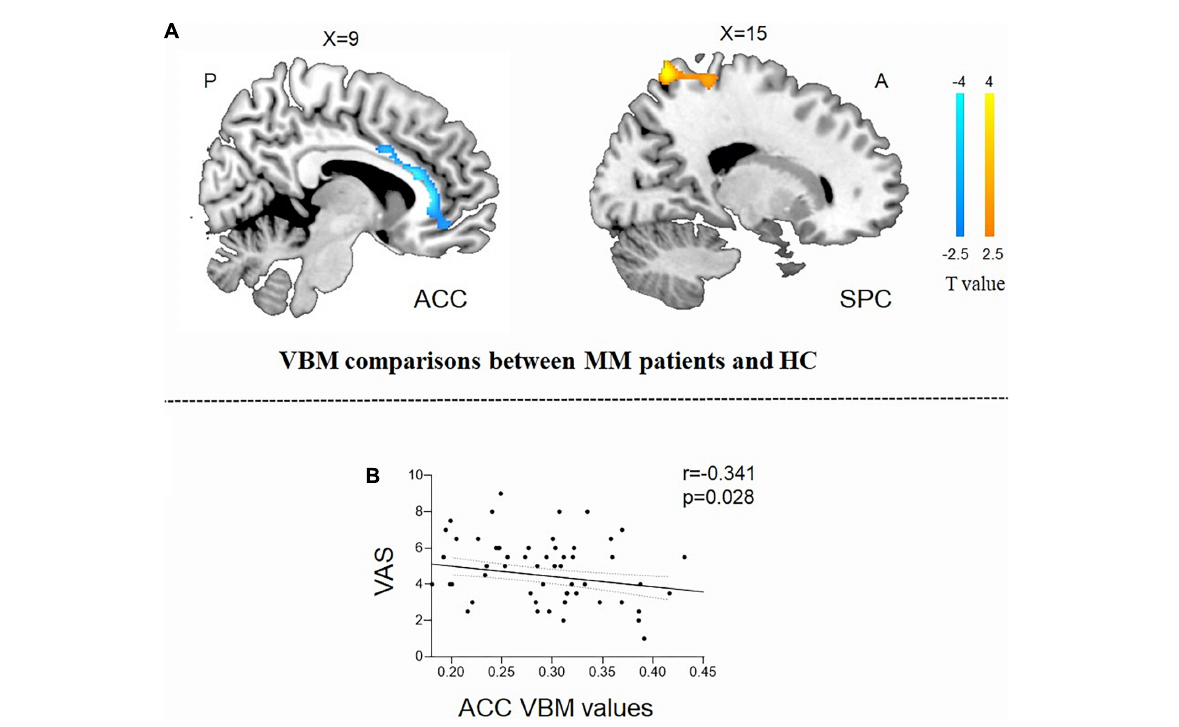
FIGURE1 Structural analysis results of patients with menstrual migraine compared with healthy controls ( P < 0.05, Gaussian random field-corrected). (A) Patients with MM showed decreased GM volumes in the ACC and increased GM volumes in the superior parietal cortex as compared to HCs. (B) Reduced GM volume in the ACC was correlated with headache intensity ( P -uncorrected). ACC, anterior cingulum cortex; GM, gray matter; VAS, visual analog scale; SPC, superior parietal cortex; MM, menstrual migraine patients; HC, healthy control.